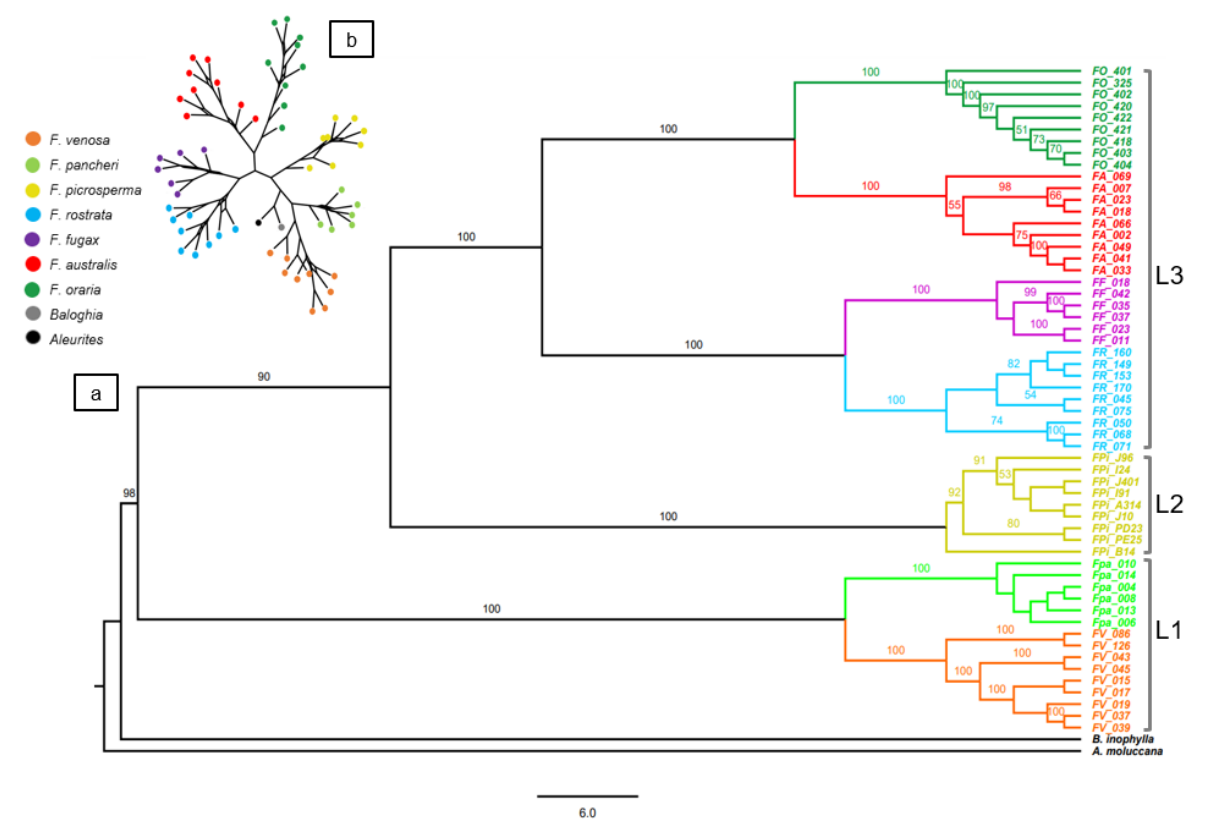
Figure 3. Phylogenetic tree with proportional terminal nodes ( a ) and consensus network ( b ) of the Austral-Pacific Fontainea complex constructed from the individually aligned and concatenated sequences of reduced-representation SNP markers (5608 loci) using a maximum-likelihood analysis. Baloghia inophylla and Aleurites moluccana were used as outgroup representatives to root the tree. The values on the phylogenetic tree at the branches represent bootstrap support (>50) based on the best-fit GTR model, and the scale bar represents substitutions per site. The three Fontainea lineages recovered (L1, L2, L3) are represented outside the tip labels of the tree. Tree and consensus network tips are coloured by species; see inset legend.